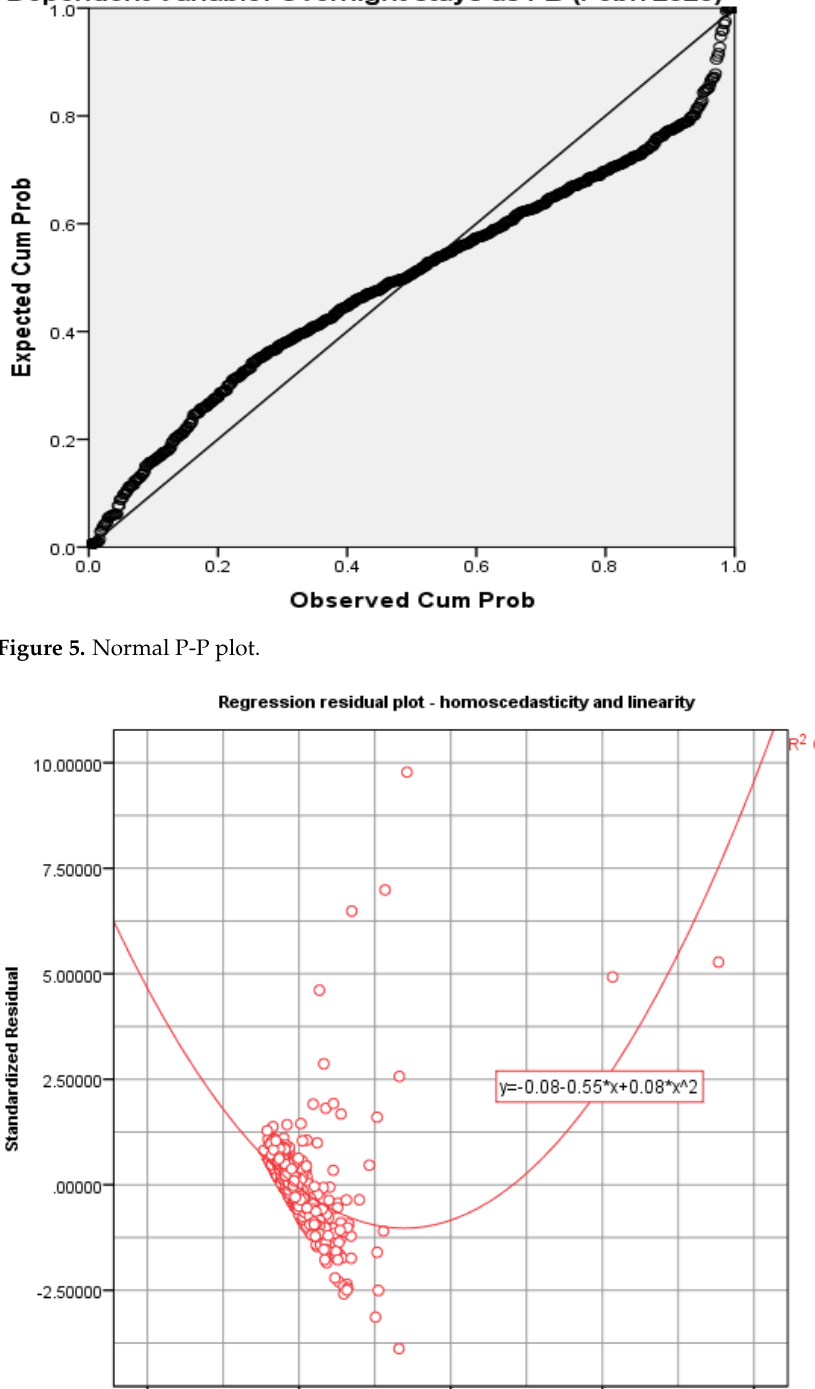
Figure 6. Regression residual plot — homoscedasticity and linearity.